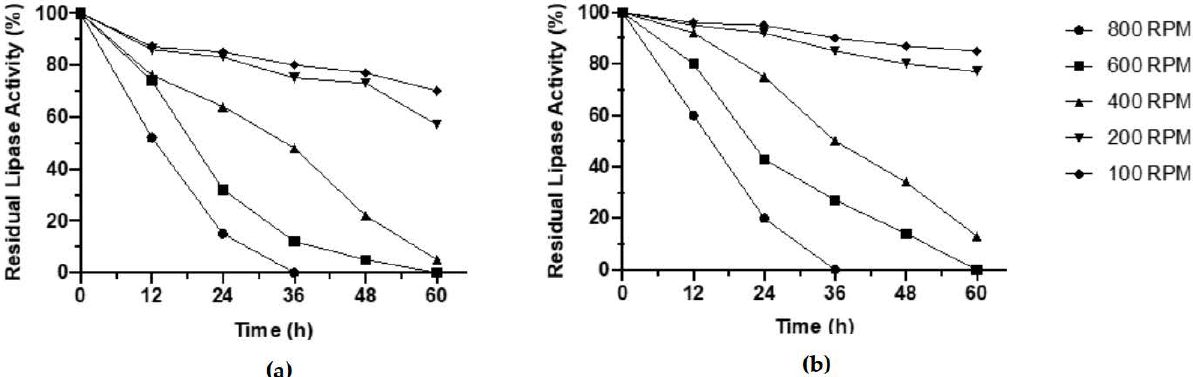
Figure 2. Effect of co-solvent concentration of residual lipase activity of N435. ( a ) Ratio 2-methylbutan-2-ol/glycerol: 1/4. ( b ) Ratio 2-methylbutan-2-ol: 1/6. All the quantifications were performed in triplicate.